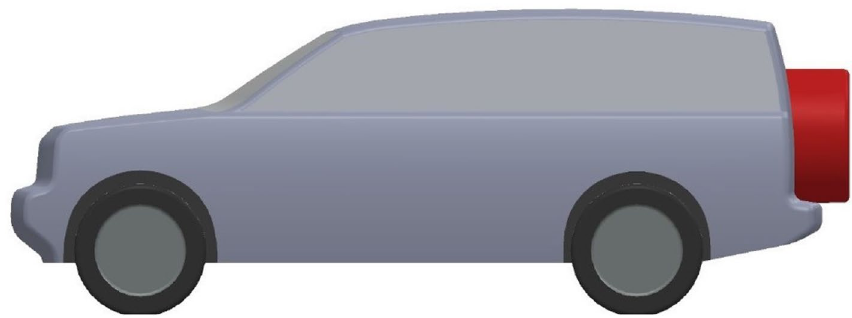
Figure 8. Side view of modified LRD4 with the spare tire.